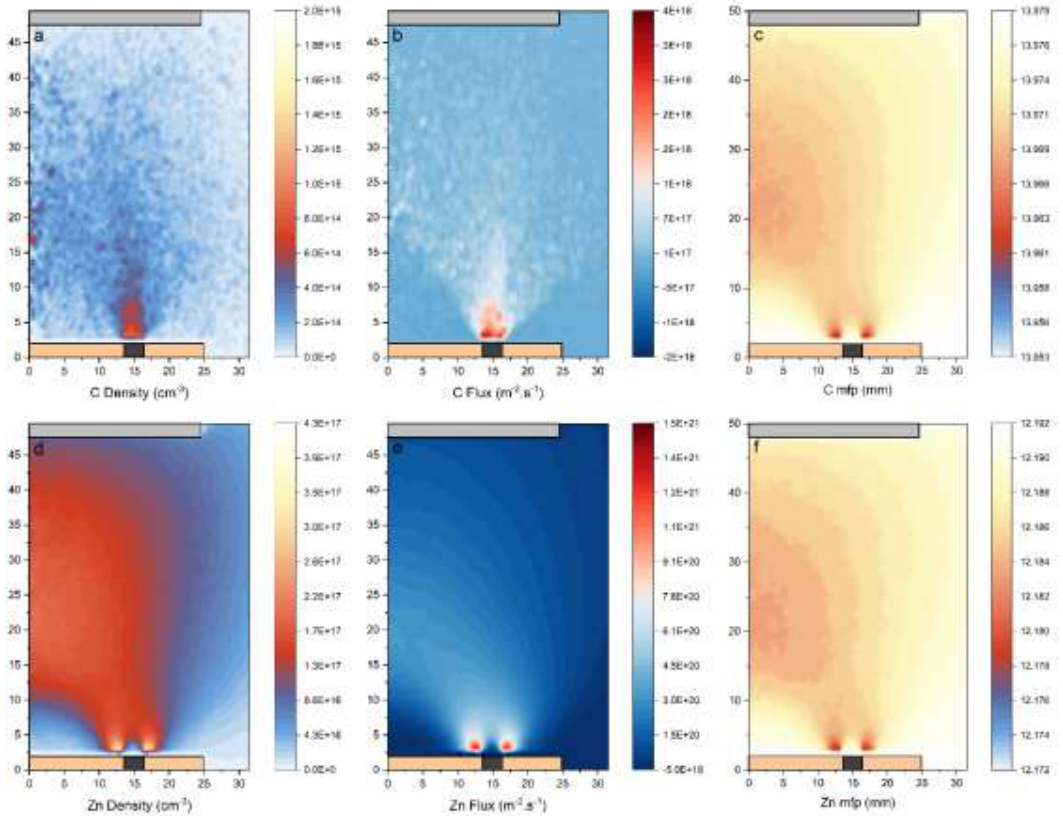
Figure 5: 2D simulation of the density of sputtered atom, the flux of particles, and mean free path for the sputtered C atoms (subfigures a, b, and c, respectively) and for sputtered Zn atoms (subfigures d, e, and f, respectively). All y- and x- axes are in mm.